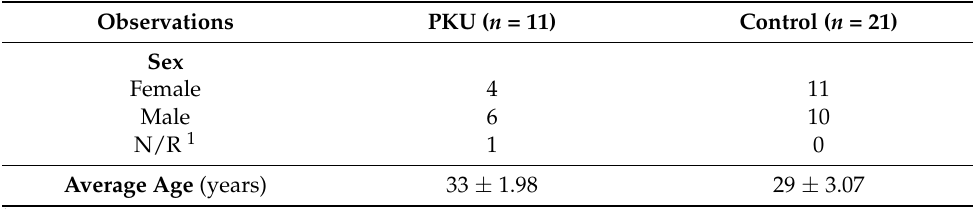
Table 1. Baseline characteristics of the